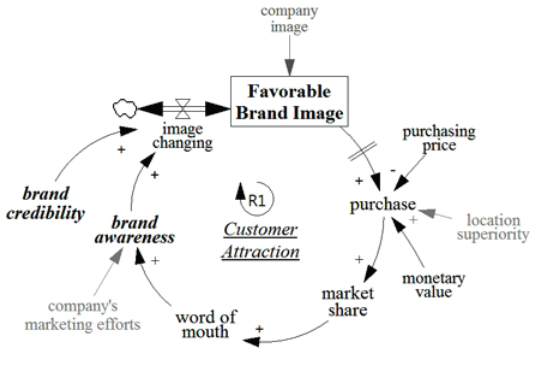
Fig. 3. Establishing favorable brand